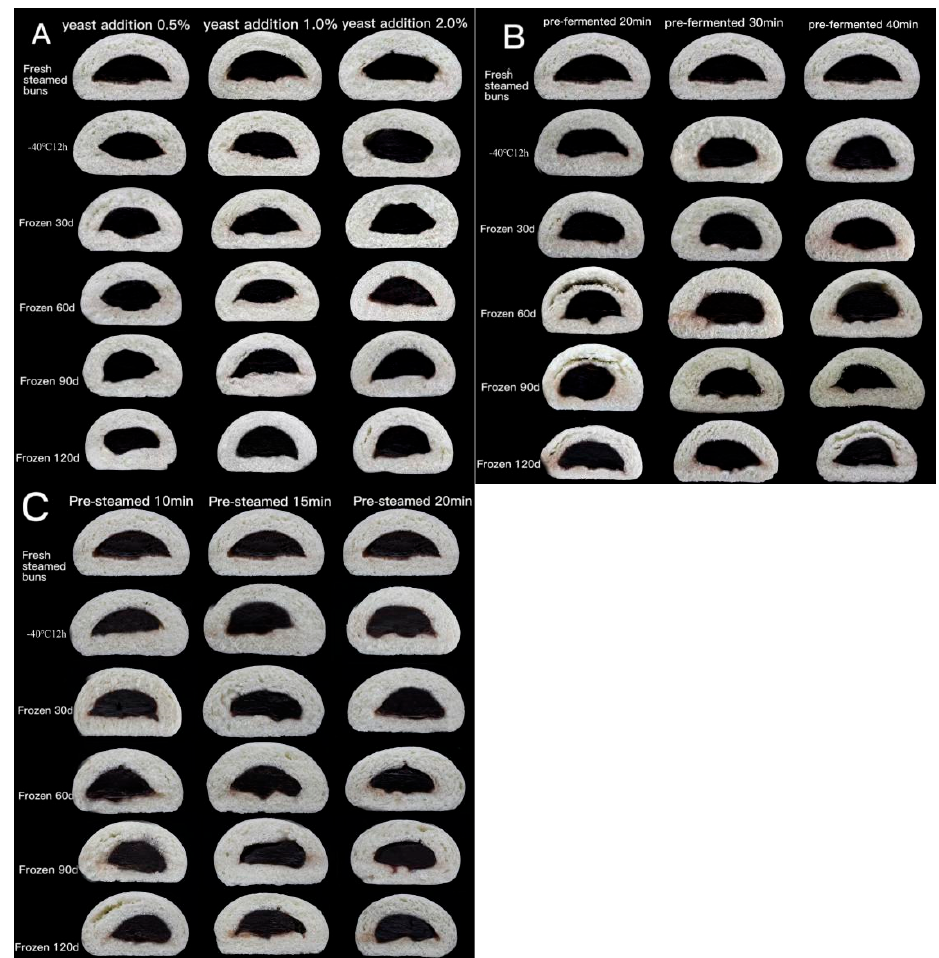
Figure 3. The cross section image of steamed buns made from un-fermented ( A ), pre-fermented ( B ) and par-steamed ( C ) frozen dough. Table 2. Effects of different processes on the internal pore structure parameters of frozen dough buns .